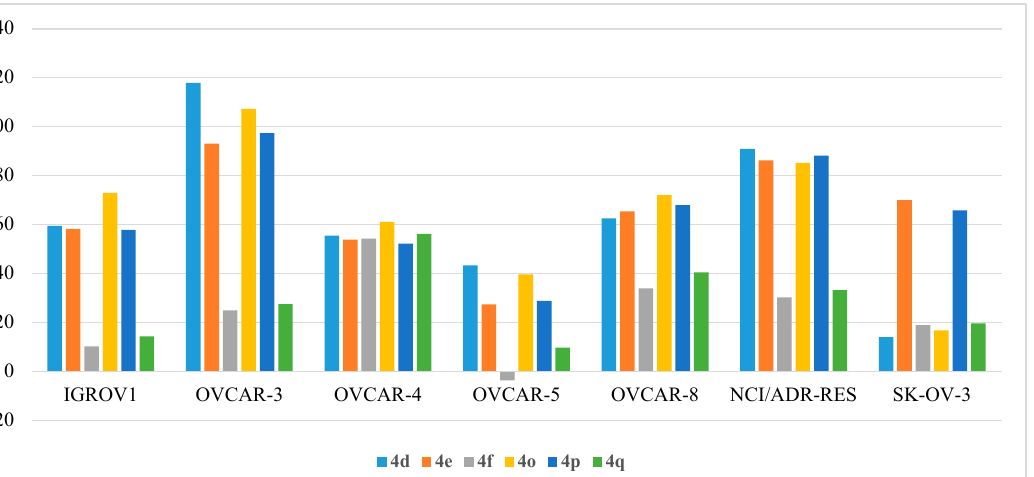
Figure 10. Anti-proliferative activities (% GI) of compounds 4d , 4e , 4f , 4o , 4p , and 4q against ovarian cancer cell lines.